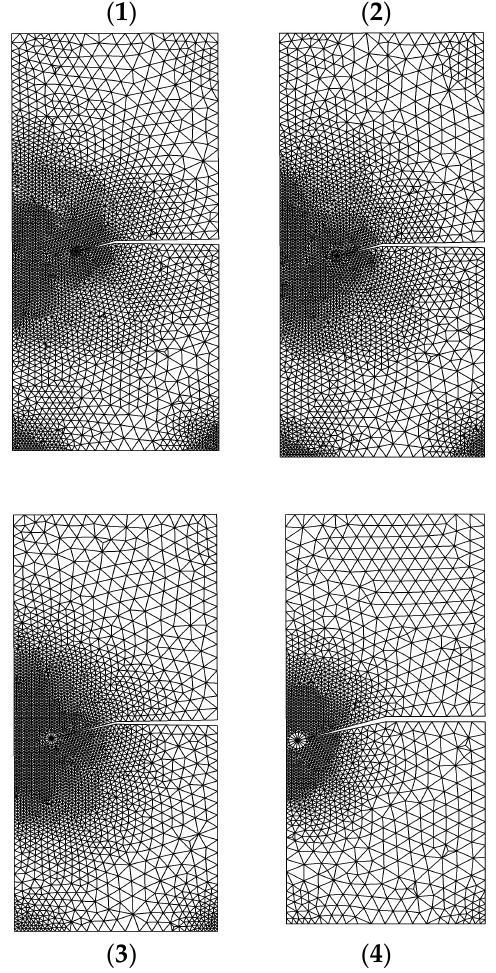
Figure 8. ( a ) The adaptive mesh, ( b ) maximum principal stress (MPa), and ( c ) von Mises stress (MPa).